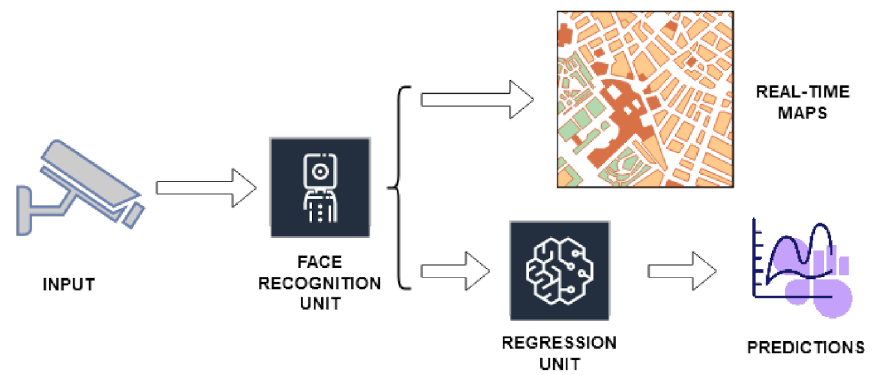
Figure 4. Flow and elements of the crowd detection method.